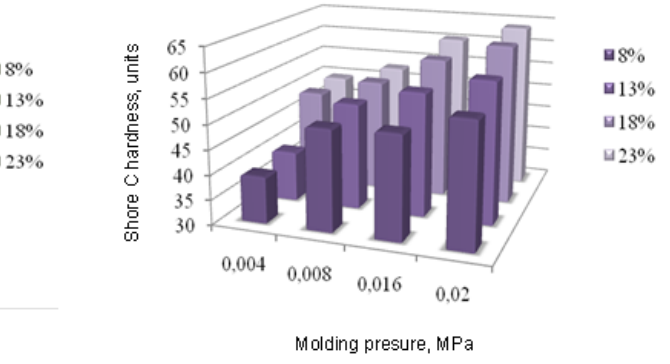
Figure 2: Shore C hardness dependence on molding pressure and content of polymer binder (8, 13, 18 and 23 wt.%